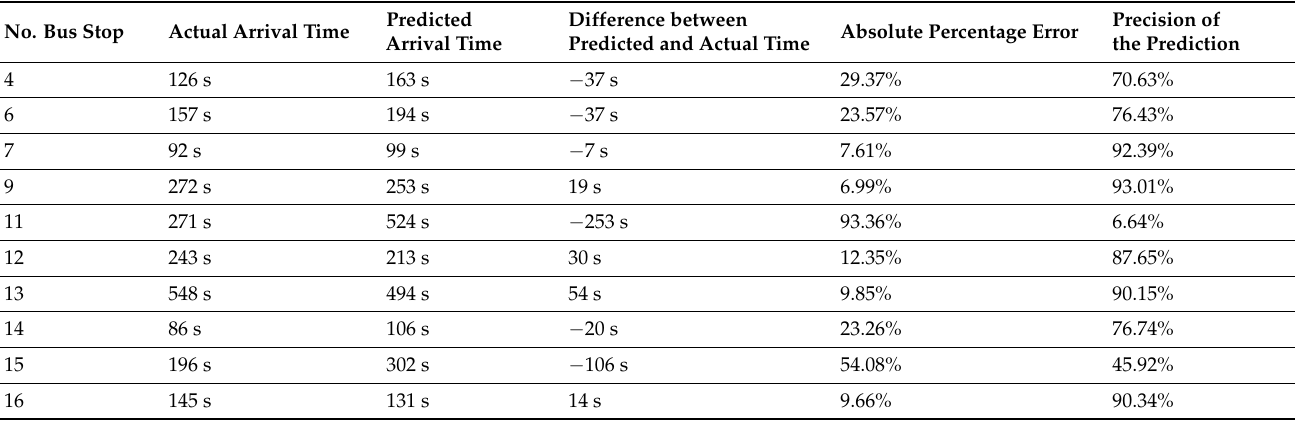
Table 7. Results obtained for Trip 7, Journey: Guacamayas–University. MAE = ± 57.7 s, MAPE = 27% Precision = 73%.